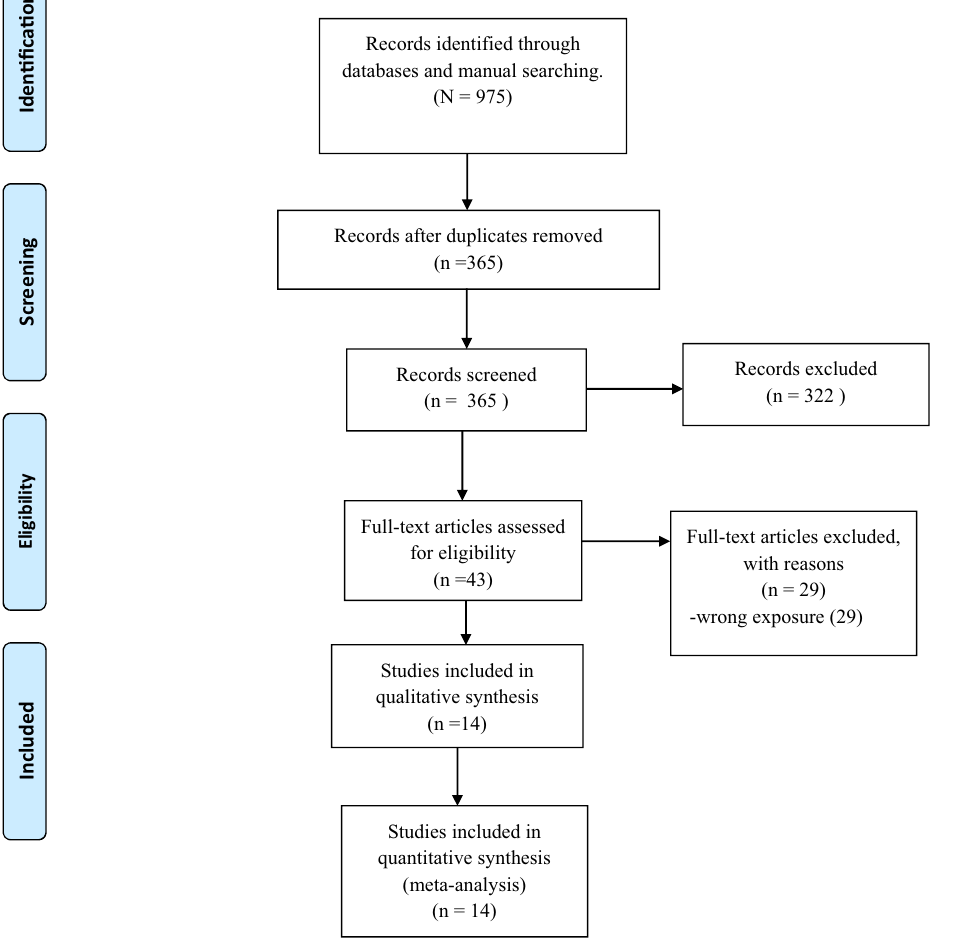
Figure 1: PRISMA fl ow